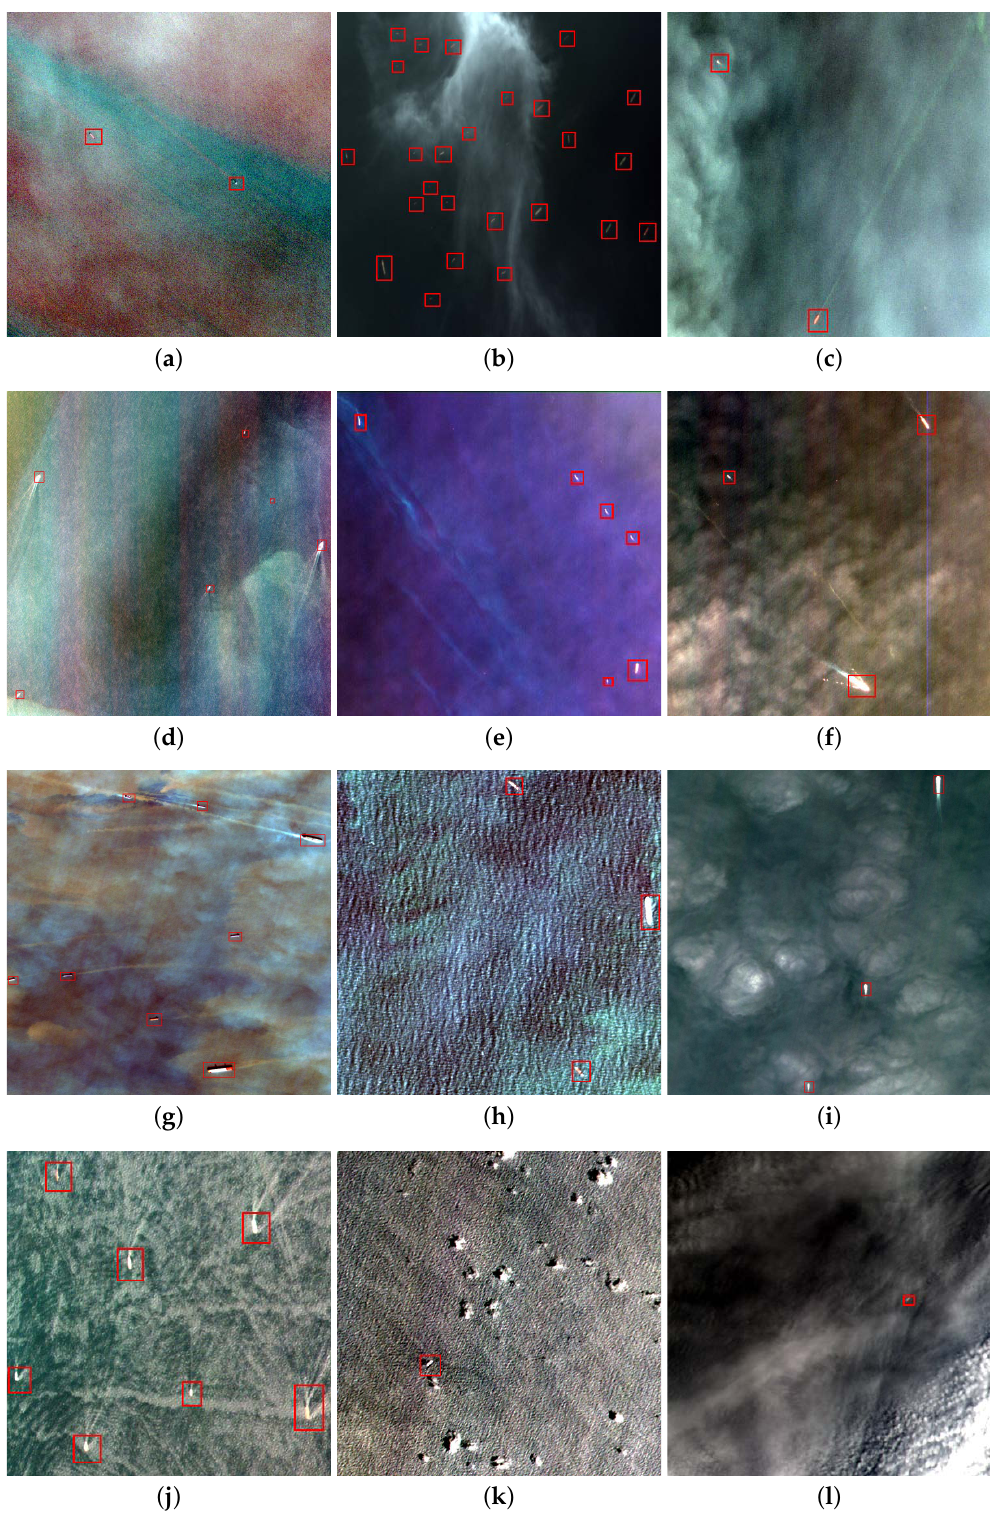
Figure 11. The performance of the proposed method under different conditions: ( a , d , g , j ) Calm, ( b , e , h , k ) waves and ( c , f , i , l ) mist and thick clouds. ( a – c ) represents images from GF1. ( d – f ) represents images from SJ9. ( g – i ) represents images from ZY3. ( j – l ) represents images from